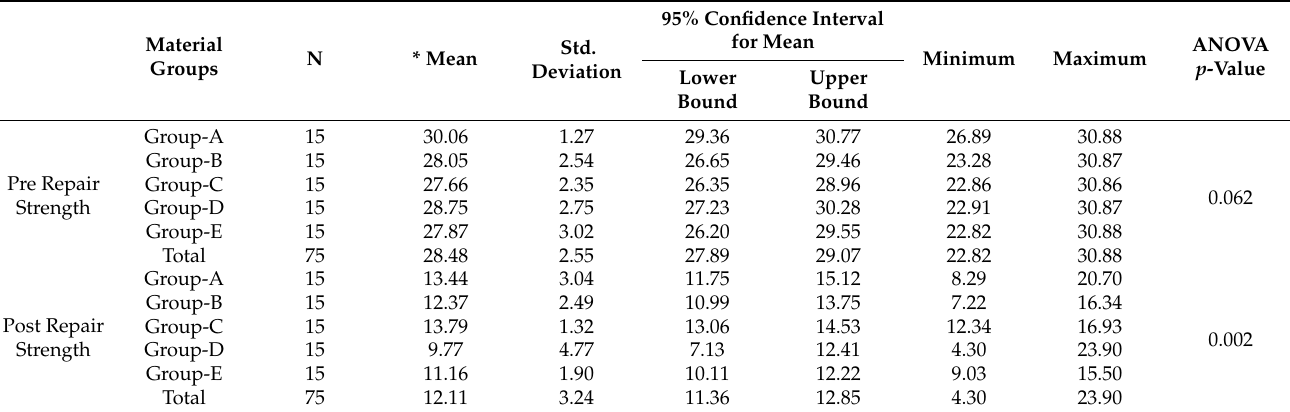
Table 3. Descriptive statistics with mean, standard deviation, and ANOVA results of shear bond strength before and after the ceramic repair (N = 150).